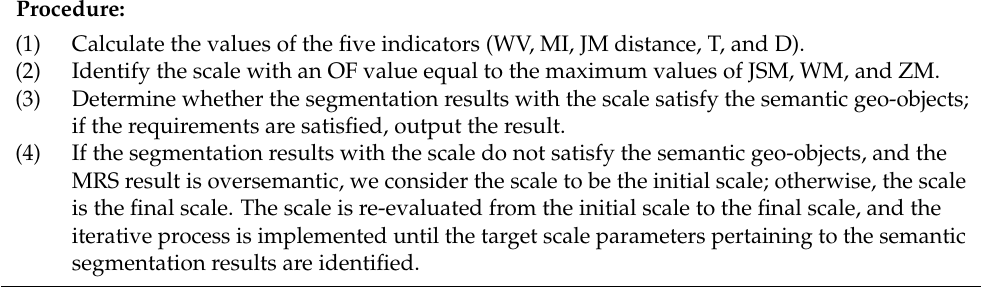
Table 2. Approach to determine the optimal semantic segmentation